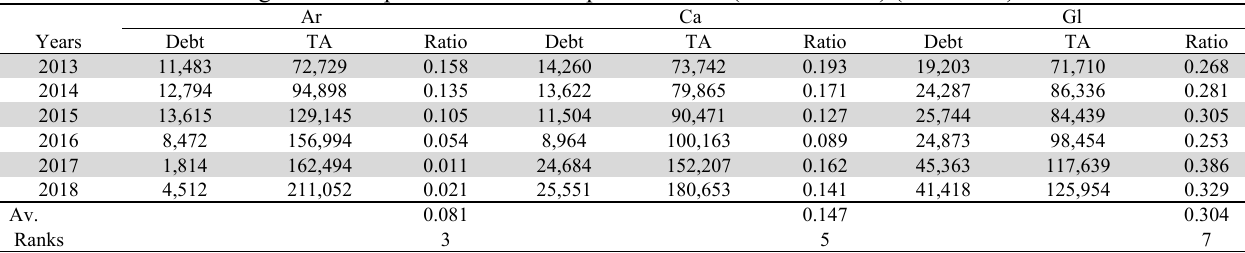
Source: Amounts of debt and equity are taken from the financial statements of the concerned companies. Debt-TA Ratio and rankings of Indian pharmaceutical companies (Rs. in Million) (Continued) Years